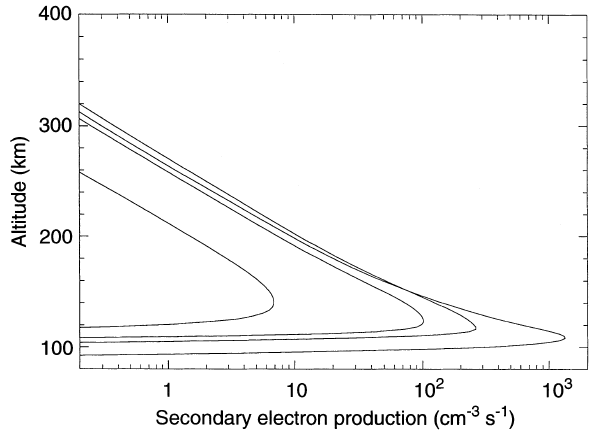
Fig. 6. Secondary electron production versus altitude. From left to right , are the secondary production for the 1 keV, 5 keV, 10 keV and 50 keV input Maxwellian proton fluxes